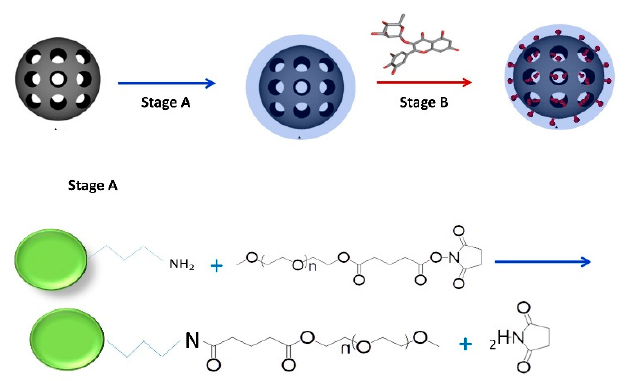
Figure 1. Synthesis of the flavonoid loaded mesoporous silica nanoparticles (MSNs). Stage A: PEGylation of propylamine MSN; Stage B: Loading of flavonoids.